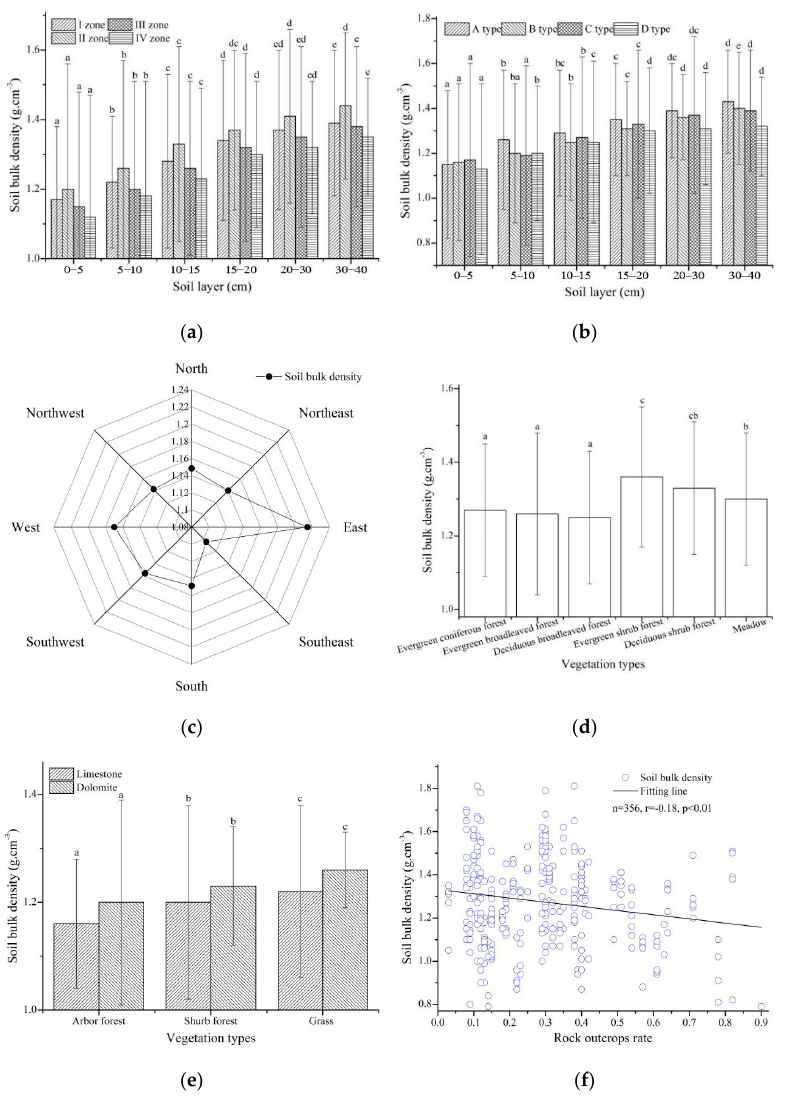
Figure 3. Information on SBD: ( a – f ) show the relationship between SBD and slope position, gradient, aspect, vegetation, lithology and rock outcrops, respectively.